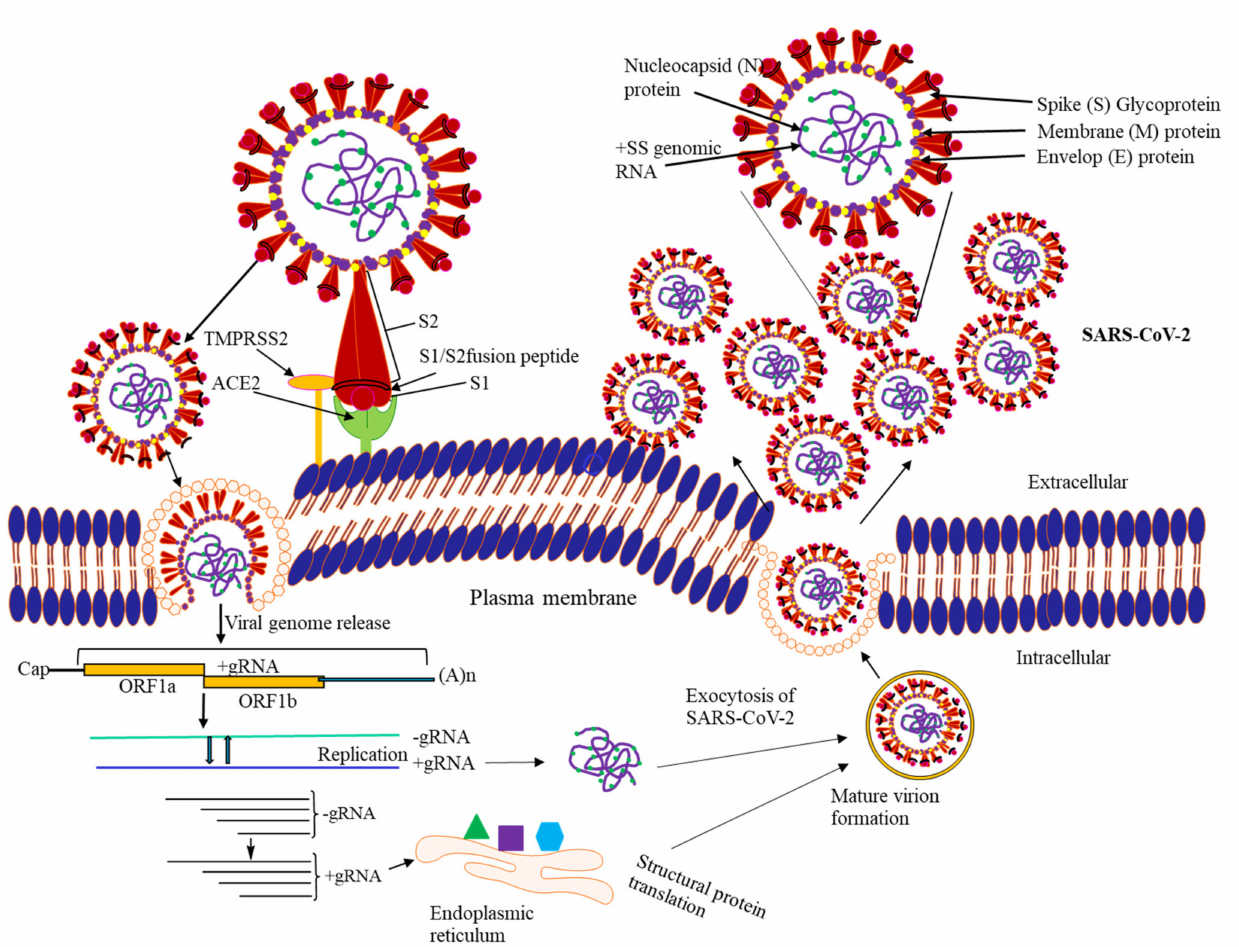
Figure 2. SARS-CoV-2 begins by binding with its S protein (RBD/S1) on host cell receptor, ACE2, driving conformational change in the S2 subunit, and thereby facilitating its fusion with plasma membrane. Immediately after release of +ssRNA, translation leads to formation of non-structural polyproteins pp1a and pp1ab, which undergo proteolytic cleavage and are eventually assembled into functional replicase. The replicase leads to formation of a negative-sense intermediate, which is eventually replicated to form multiple copies of gRNA as well as nested set of sgRNA by discontinuous transcription. These sgRNA are translated into various structural and accessory proteins, which are assembled as virion in the ERGIC, and eventually exit cell via